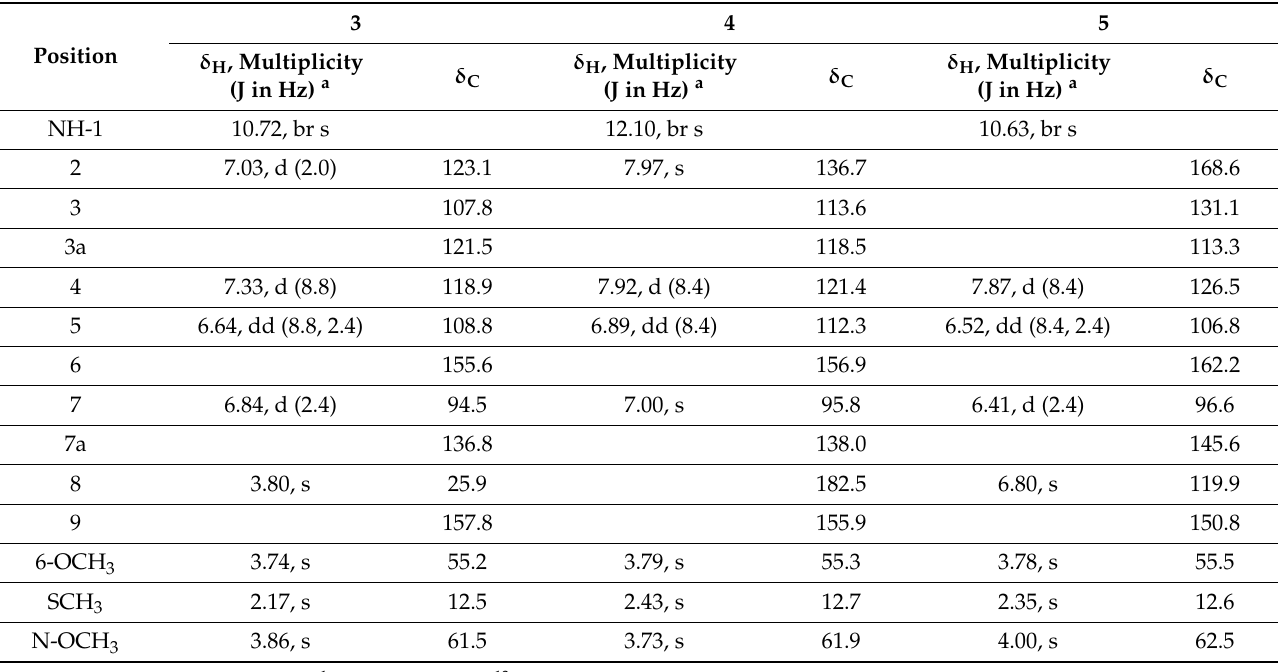
Table 2. 1 H- and 13 C-NMR data for compounds 3 – 5 .